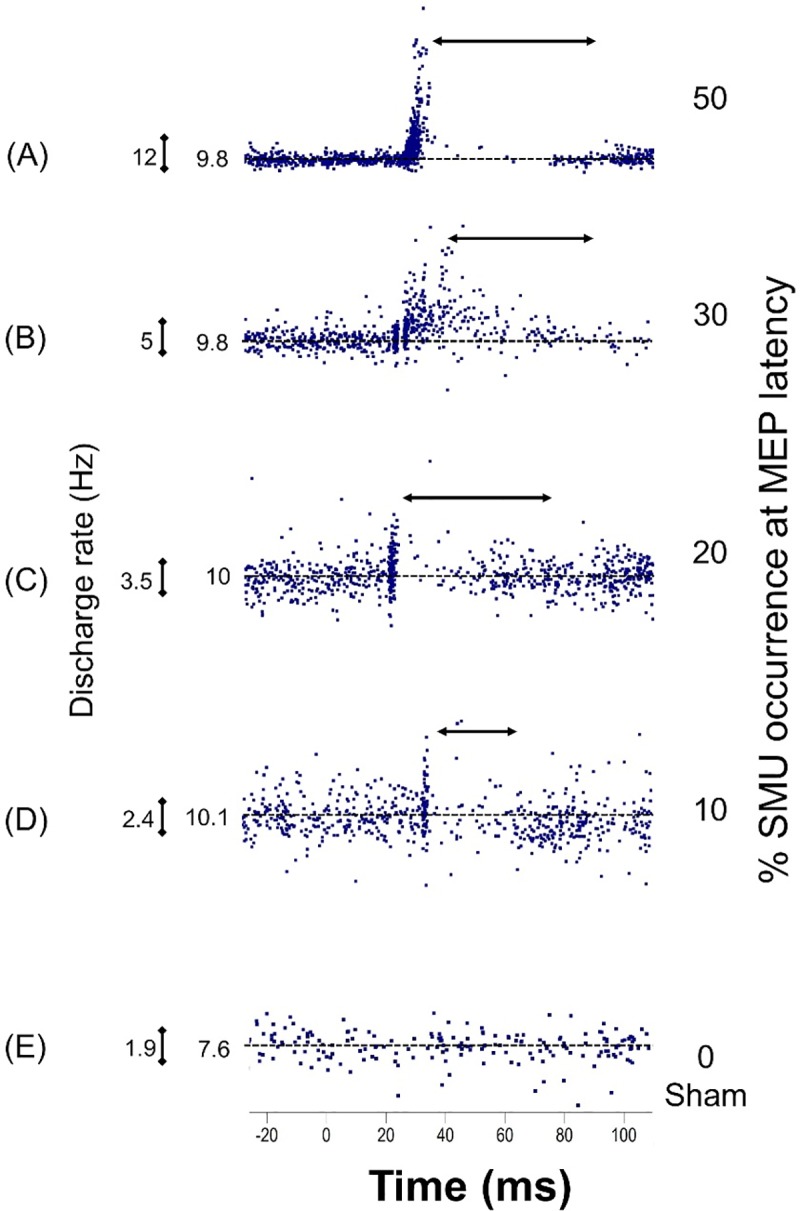
Representation of discharge rates (PSF) in different TMS intensities in TA muscle.The horizontal arrows indicate duration of the TMS induced CSP. Latency was calculated using PSTH-CUSUM and the duration using PSF-CUSUM. The intensities which evoked (A) 50, (B) 30, (C) 20, (D) 10-unit potentials at the MEP period per 100 stimuli, and (E) sham TMS without any MEP. Note that in 30/100 intensity, the motor unit responses during MEP clearly indicate I1 and I2 responses. In all cases, average the discharge rates of SMUs and scalebars that indicate calibrations in each trace are shown.